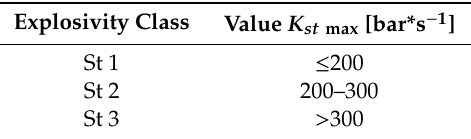
Table 3. Classes of dust explosivity